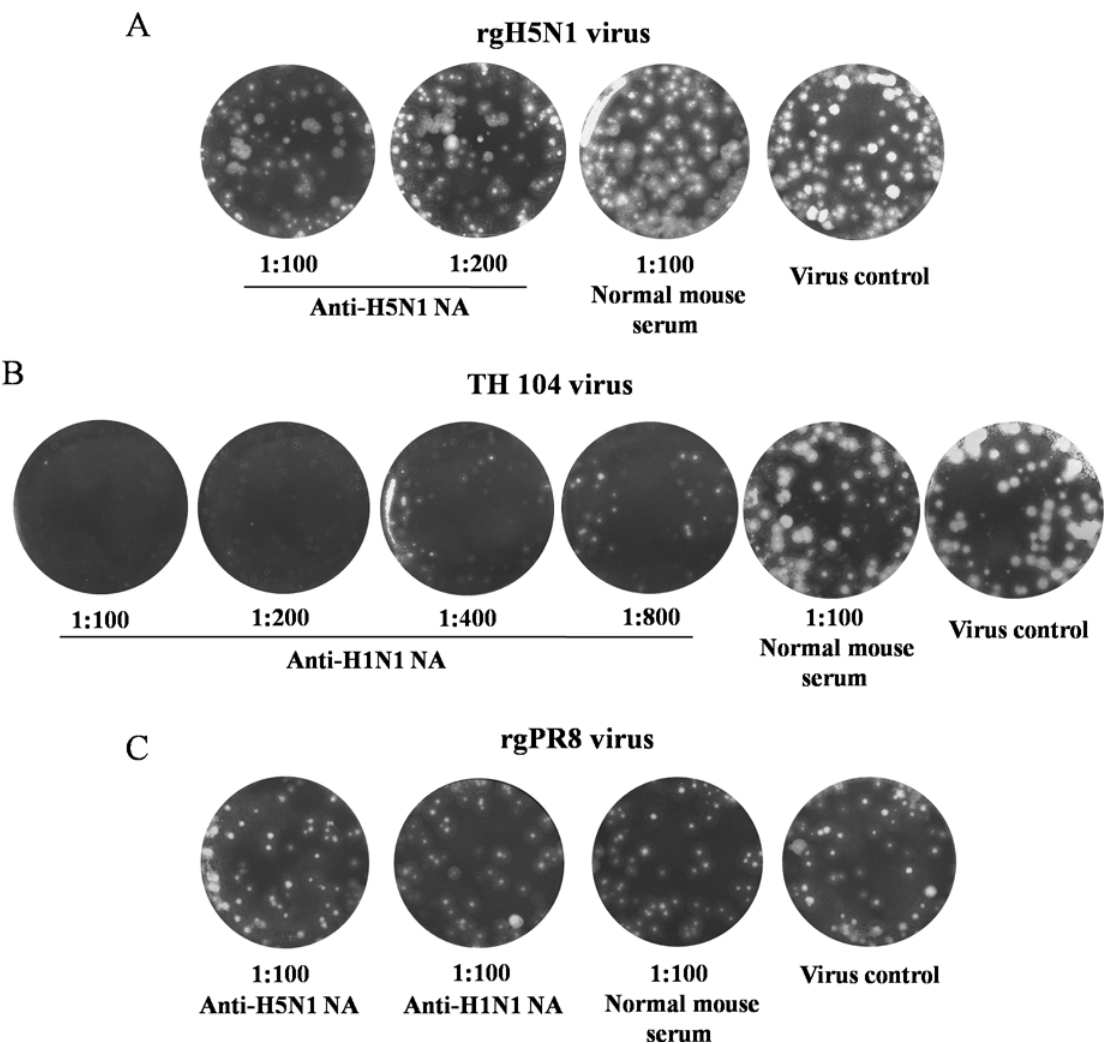
Fig 8. Inhibitory effect of anti-H5N1 NA and anti-H1N1 NA antisera determined by plaque reduction assay in MDCK cell monolayers. The results demonstrate the reduction in number of plaques and plaque size mediated by anti-H5N1 NA and anti-H1N1 NA antisera compared to normal mouse serum and virus controls. Pooled mouse sera collected at 6 weeks p.i. were employed in the